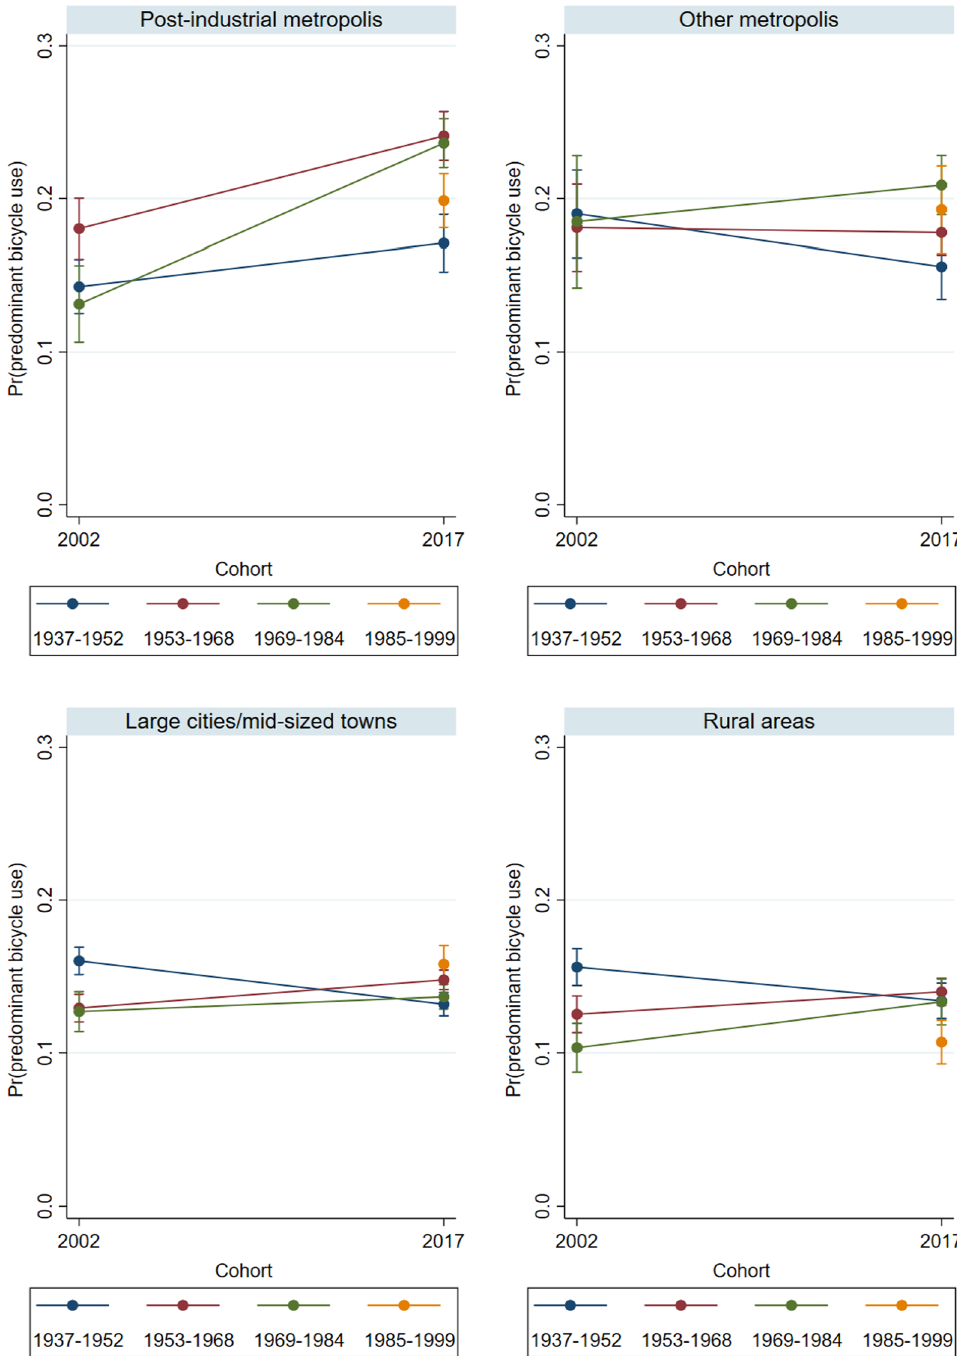
Fig. 6 Predicted probabilities of predominant regular bicycle use in 2002 and 2017 – by settlement type (Model 2). Source: Mobility in Germany: MiD person-time-series dataset (own calculations). Note: Predominant bicycle use is defined as (almost) daily bicycle use and car use of at most 1 to 3 times per week. Survey weights are applied. See also Table 5 for main effects and standard